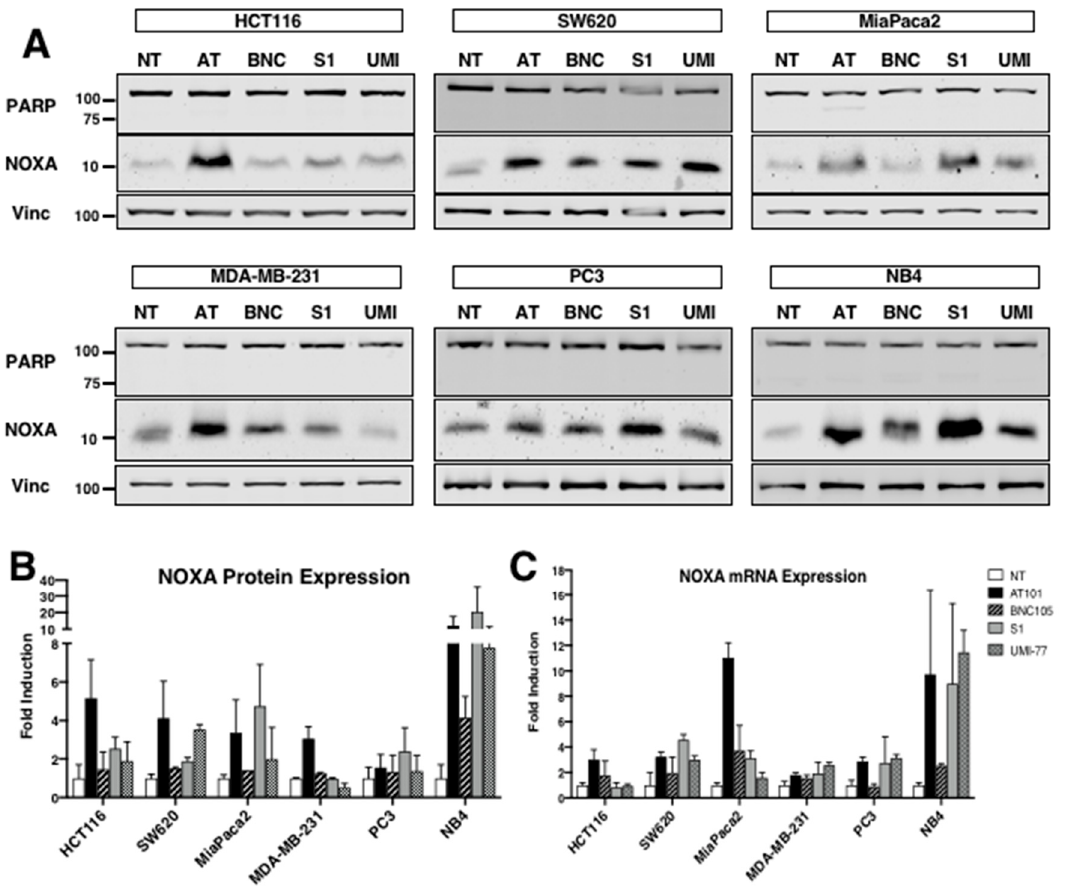
Figure 1. Induction of NOXA by BH3 mimetics. ( A ) Six cell lines were incubated with either 10 μ M AT101 (AT), 1 μ M BNC105 (BNC), 20 μ M S1 (S1) or 30 μ M UMI-77 (UMI) for 6 h and assessed for PARP cleavage as a marker of apoptosis, NOXA and vinculin expression by Western blotting. NB4 is a hematopoietic cancer cell line while the others are carcinoma cell lines. ( B ) NOXA signal intensity was measured with the Odyssey CLx Imager (LI-COR) for each cell line and expressed relative to the untreated cell lysates. Error bars represent range ( n = 2) except for MiaPaca2 BNC105 ( n = 1). ( C ) NOXA mRNA from similarly incubated cells was quantified using qPCR. Error bars represent the range of fold-change values ( n = 3).